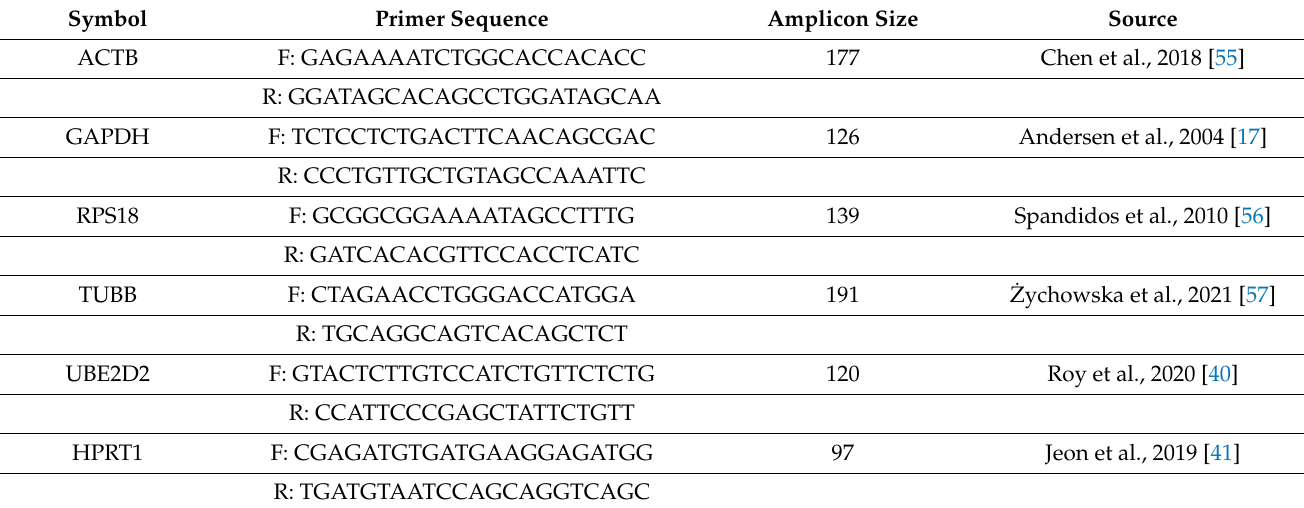
Table 2. Primer sequences, amplicon size and source for the sequences for each of the tested